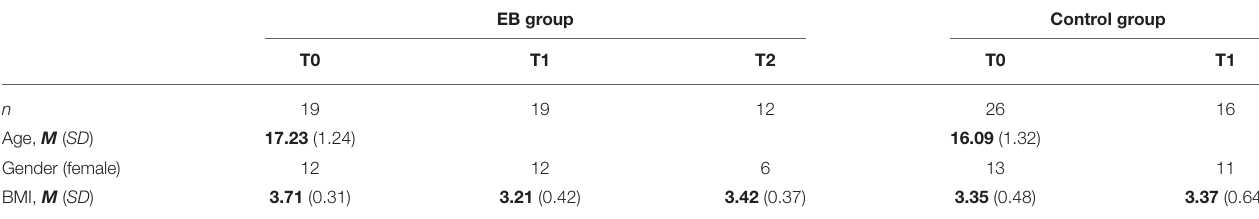
TABLE 1 | Sample characteristics for intervention and control group at baseline (T0), after 12 months (T1), and 12 months after the device removal